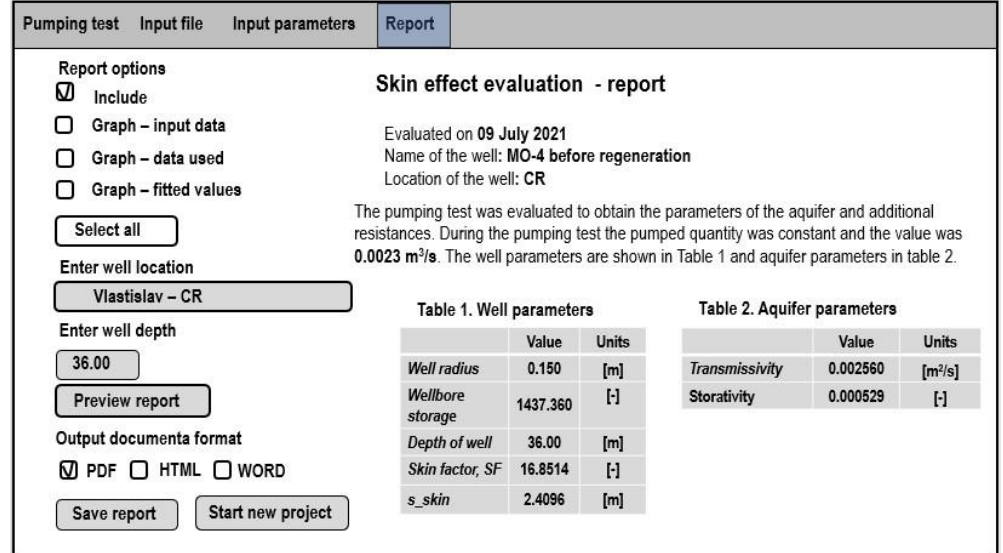
Figure 11. Dtest_ULTRA software demonstration.